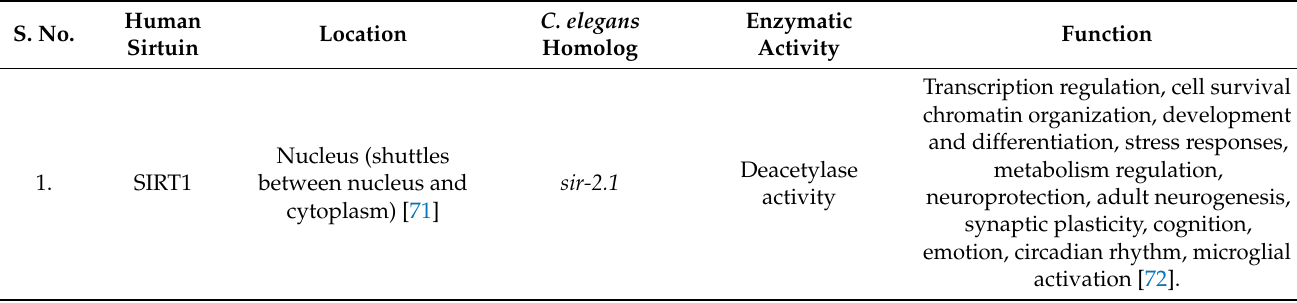
Table 2. Human sirtuins and their C. elegans homologs; enzymatic activity and function. S. No.